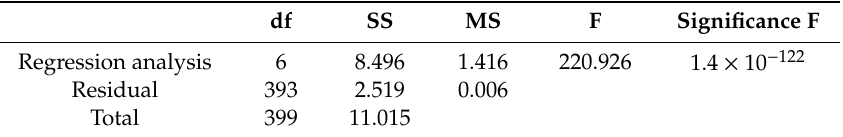
Table 6. Analysis of variance (ANOVA)